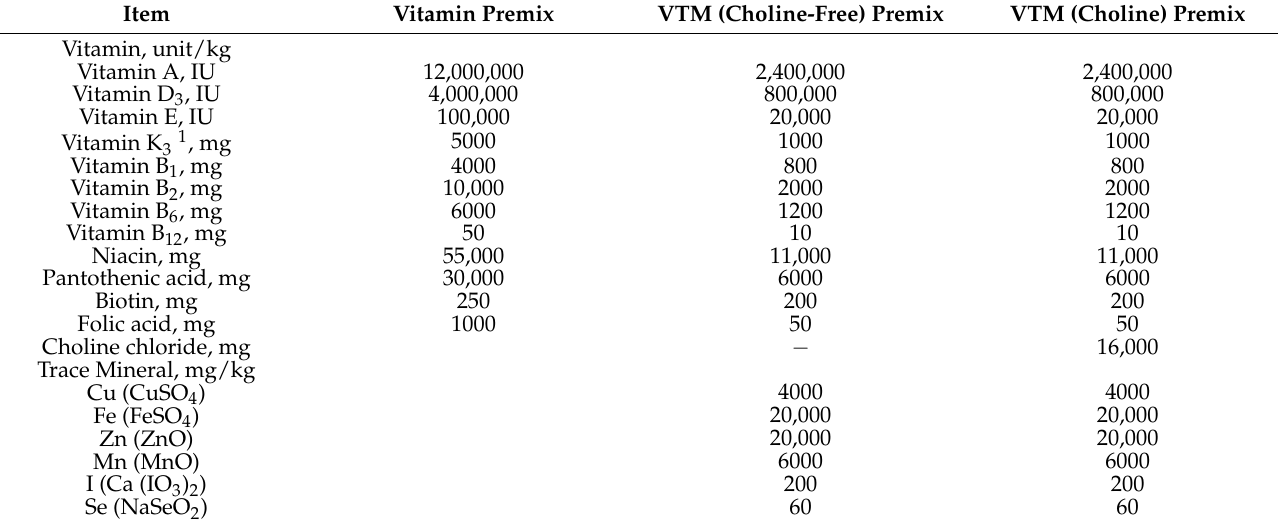
Table 1. Composition of the vitamin and vitamin-trace mineral (VTM)